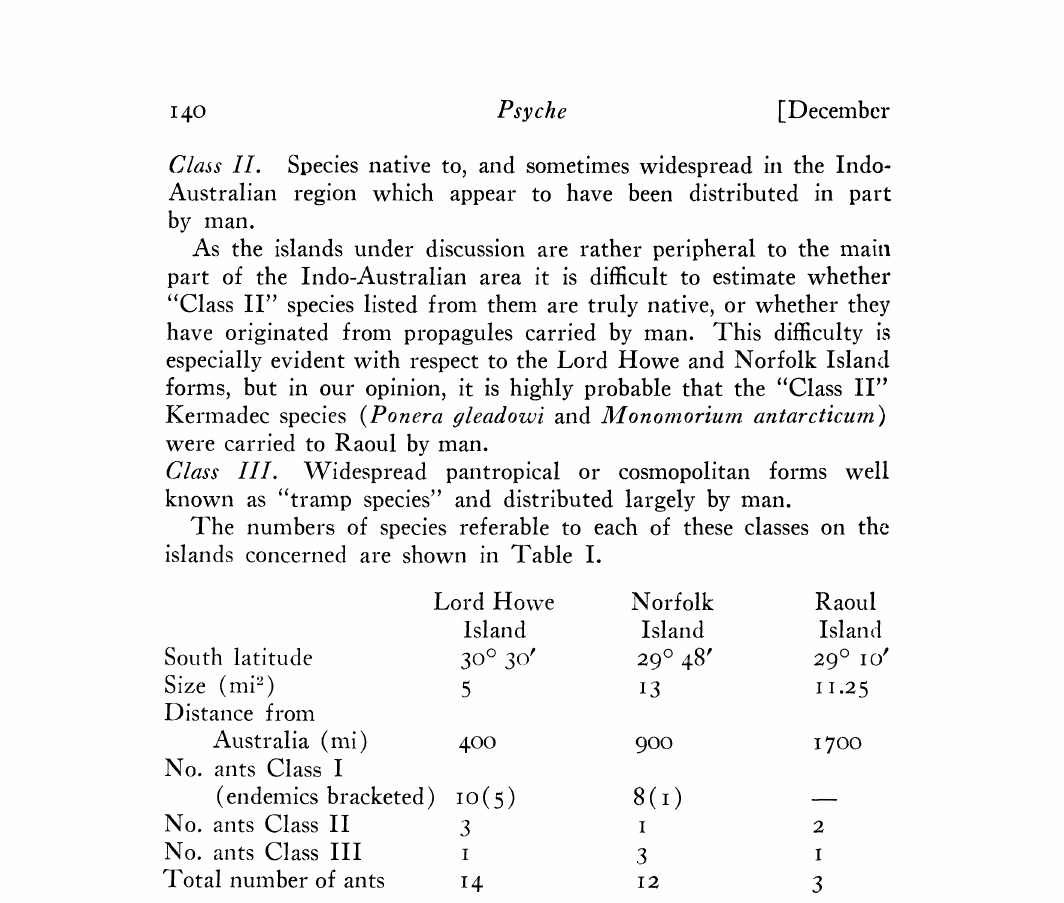
Table I. Certain geographical features of Lord Howe Island, Norfolk Island, and Raoul Island; with details of the class composition of their